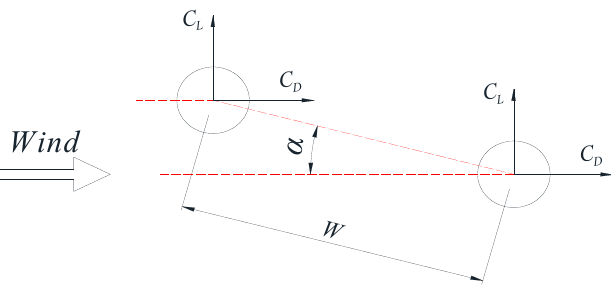
Figure 2. Relative position of twin cylinders and definition of force coefficients.